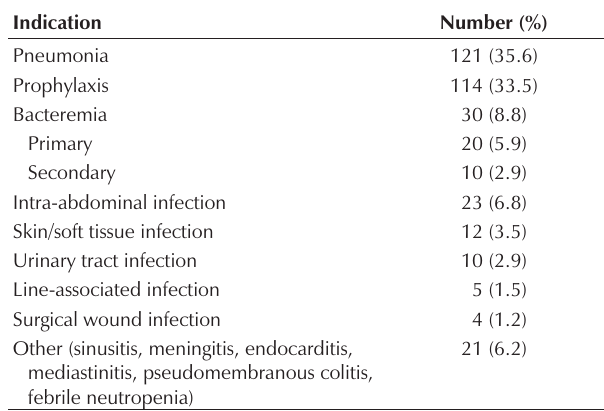
Indications for antimicrobial